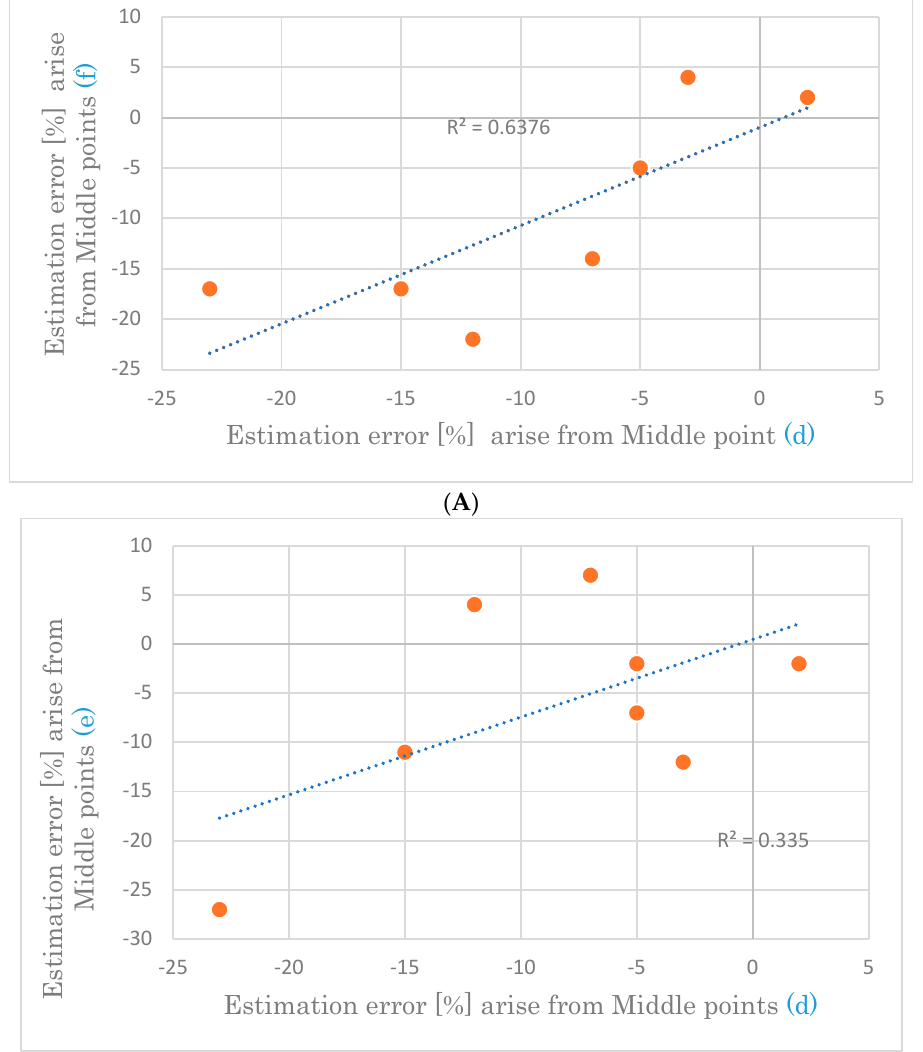
Figure 11. Error in compressive strength estimation. ( A ) Closeness of estimation error between middle points (d) and (f); ( B ) Closeness of estimation error between middle points (d) and (e).